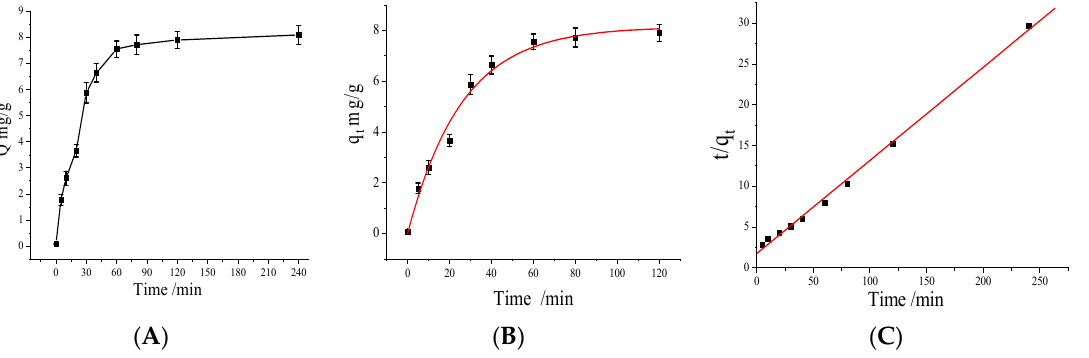
Figure 8. Effect of time ( A ), pseudo-first-order ( B ) and pseudo-second-order ( C ) kinetic models for Cu(II) adsorption. V = 1.0 mL, m = 3.0 mg, C i = 1.0 mmol/L, temperature 15 °C, pH 7.0, time 2 h. Table 1 Adsorption kinetic parameters for Cu(II) adsorption on MNPs.